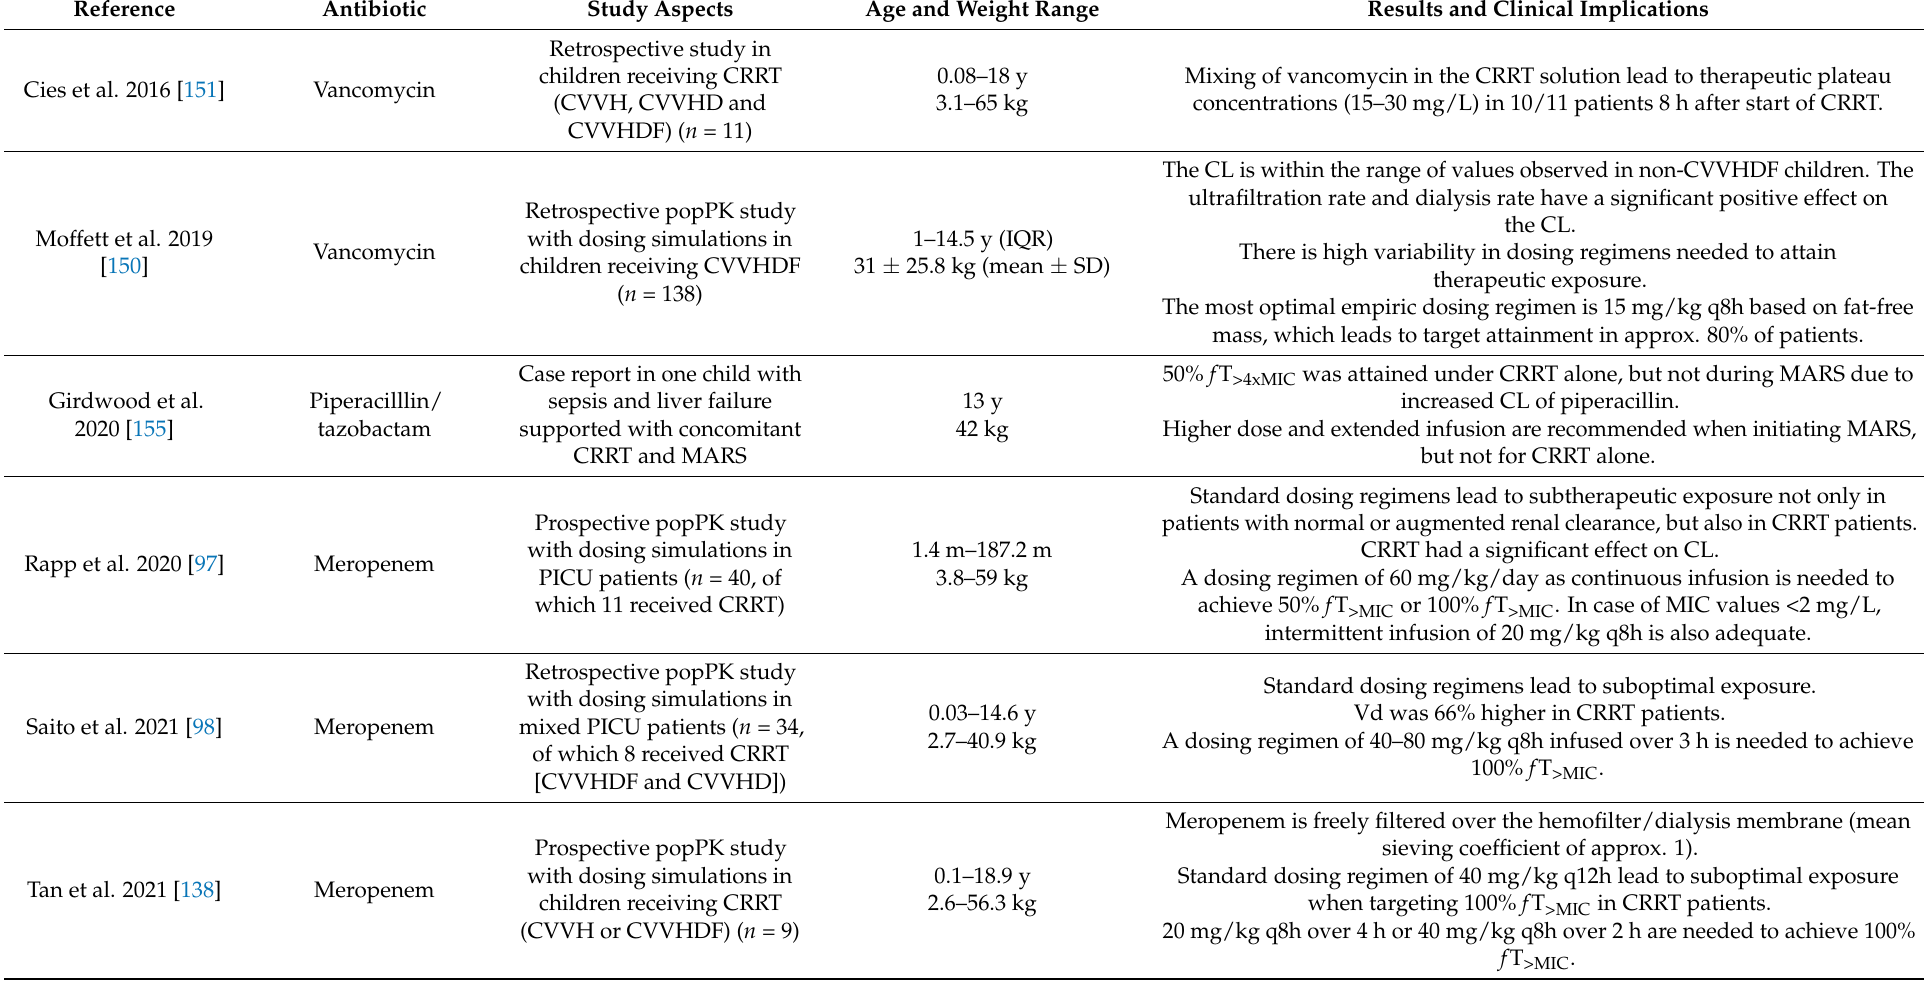
Table 7. Overview of all antibiotic PK studies performed in critically ill children and neonates supported with continuous renal replacement